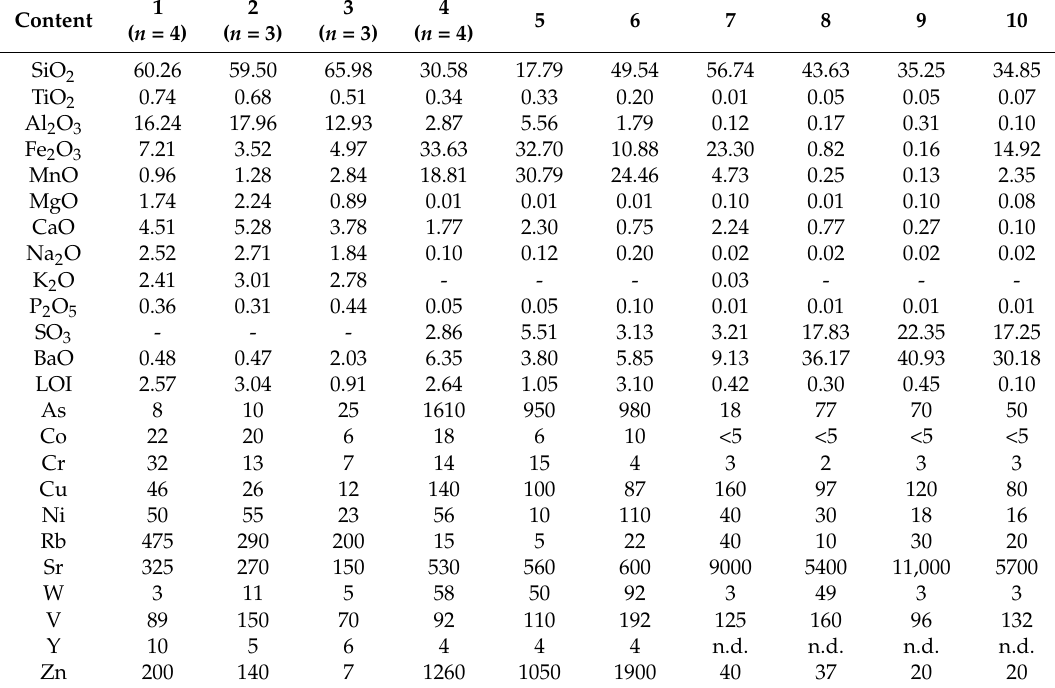
Table 3. Chemical composition of altered andesite and ore veins at Tumanpınarı (Major element in %, trace- and rare-earth elements in